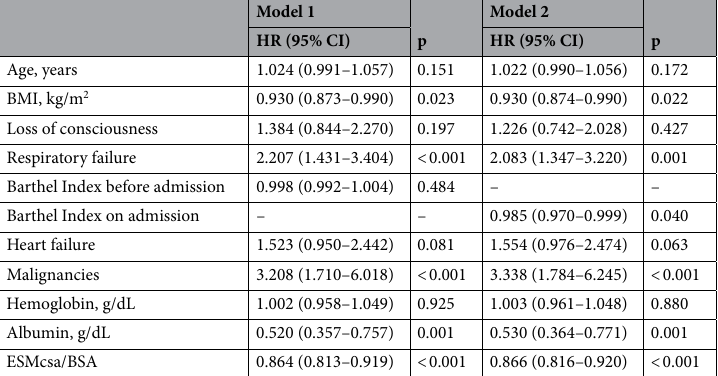
Table 3. Multivariate Cox proportional hazards analyses of all-cause in-hospital mortality. Data are presented as the number (%) or mean ± SD. BMI body mass index, BSA body surface area, CI confidence interval, ESM erector spinae muscle, ESMcsa cross-sectional area of ESM, HR hazard ratio, SD standard